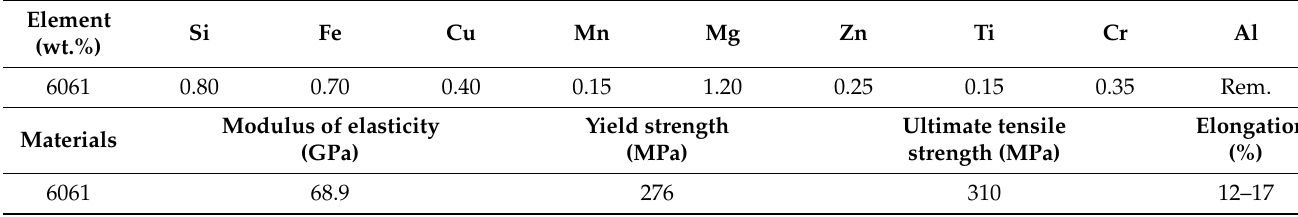
Table 2. Chemical composition and mechanical properties of SSM6061 aluminum